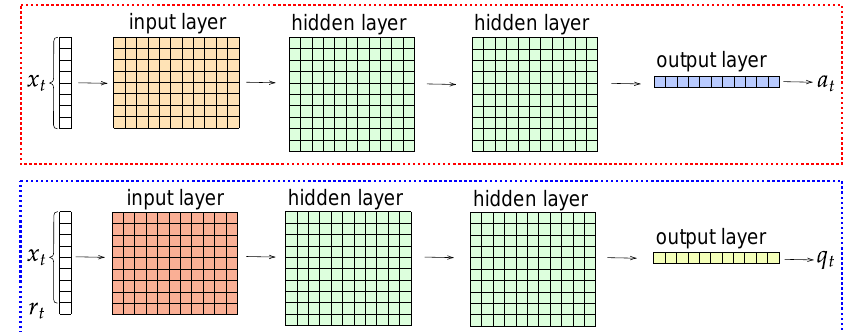
Figure 8. Layers of the Actor ( top ) and the Critic ( bottom )